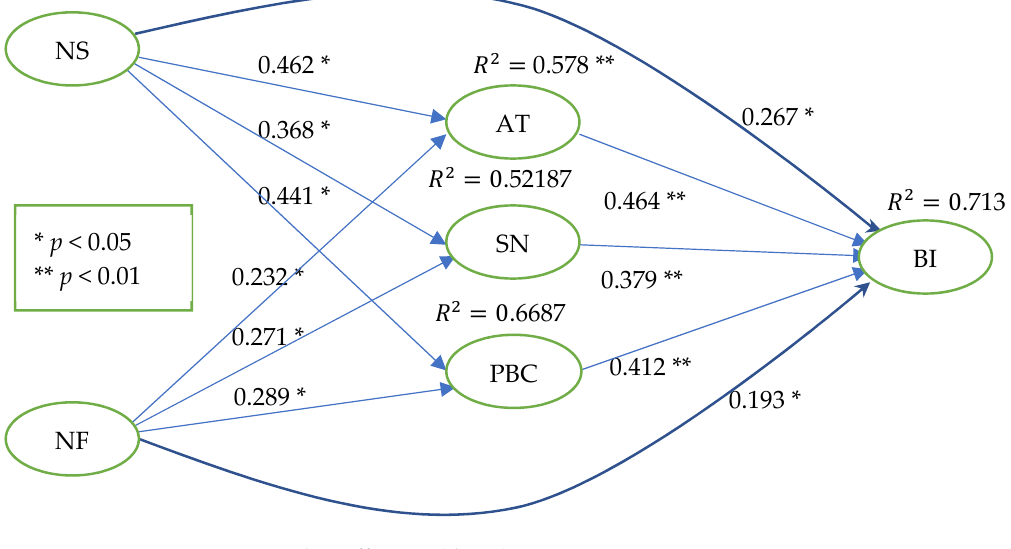
Figure 2. Path coefficients (direct).